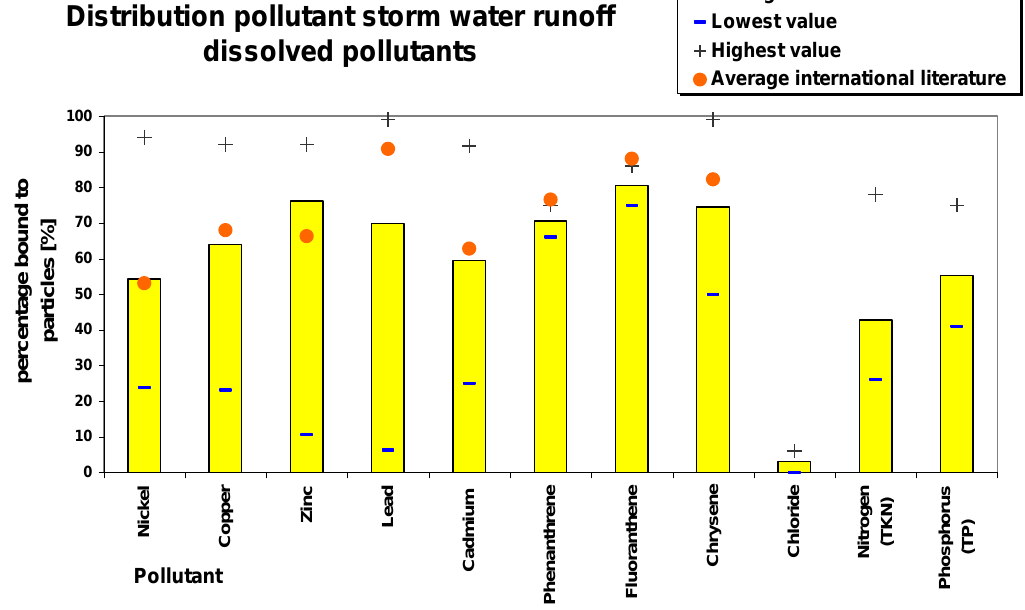
Figure 2. Distribution of pollutants in (Dutch) stormwater (90 samples from 25